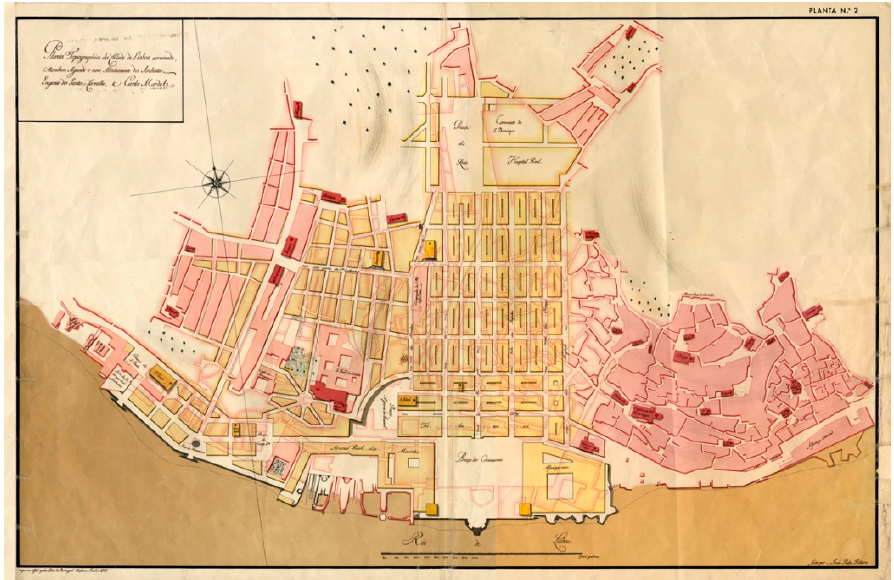
Figure 7. Reproduction of the “Topographic plant of the ruined city of Lisbon” [30].